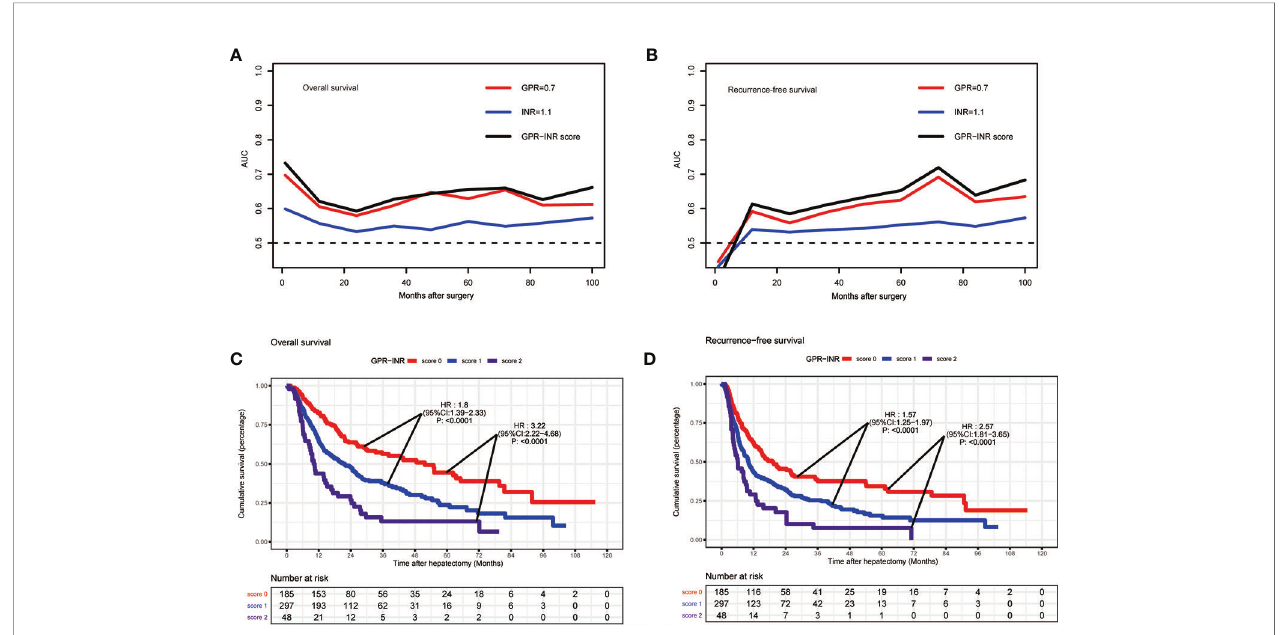
FIGURE 1 | The predictive ability of GPR-INR score for OS and RFS in the derivation set. (A, B) The time-dependent AUC curves of GPR, INR and GPR-INR score, the AUROC of the GPR-INR score was higher than that of the GPR and the INR for RFS and OS prediction. (C, D) Kaplan – Meier curves of the patients in the derivation set for OS and RFS, GPR-INR score 1 had better RFS and OS than GPR-INR score 2, worse RFS and OS than GPR-INR score 0.